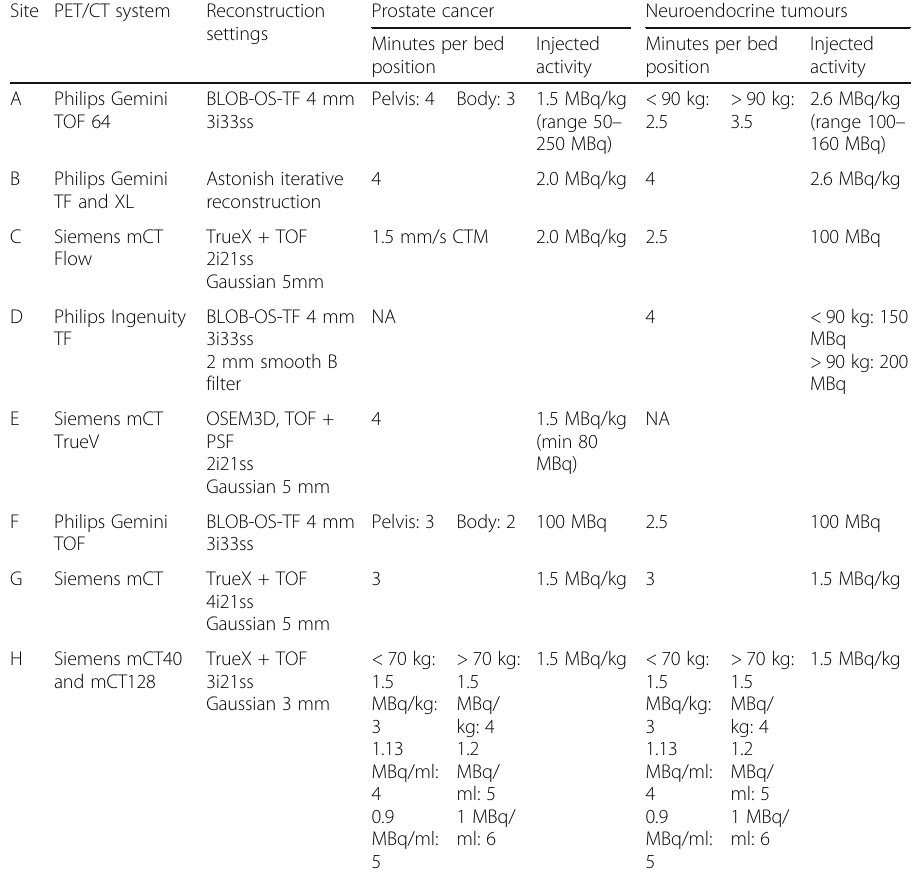
Table 1 Acquisition and reconstruction settings of clinical 68 Ga PET/CT imaging for prostate cancer and neuroendocrine tumours. One hospital per row is presented Site PET/CT system Reconstruction